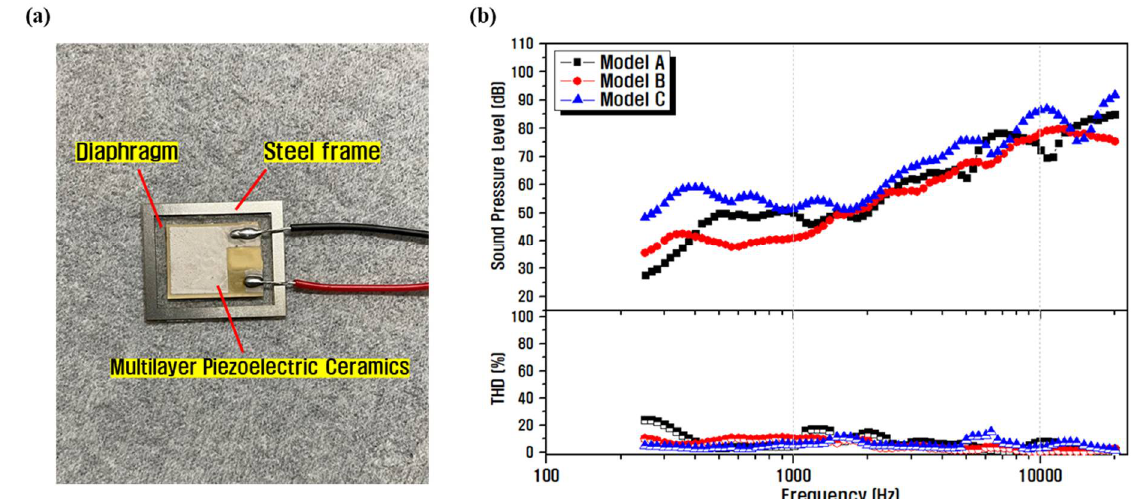
Figure 9. ( a ) A representative fabricated piezoelectric speaker. ( b ) SPL and THD characteristics of the fabricated speaker.